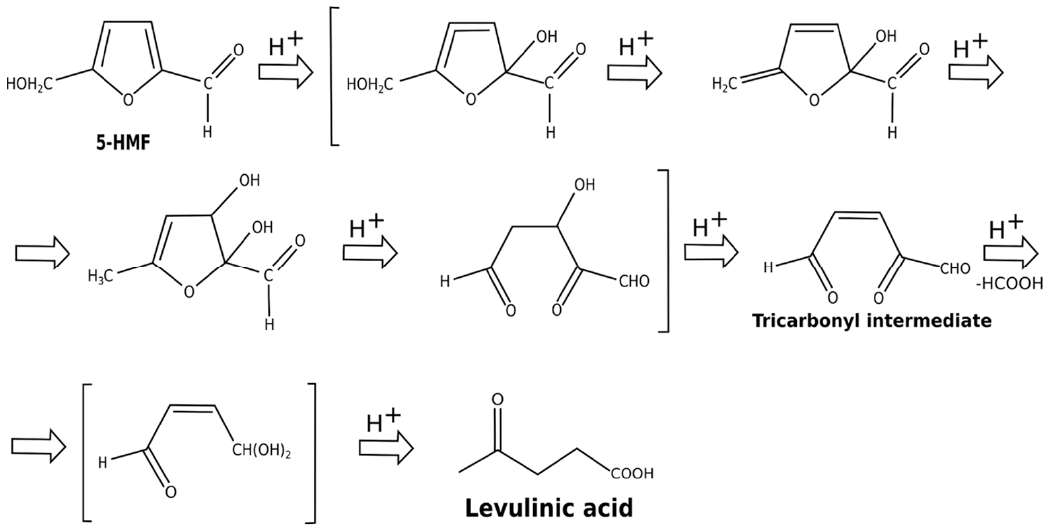
Figure 2. Detailed mechanism for the formation of LA from 5 ‐ HMF in acid medium.